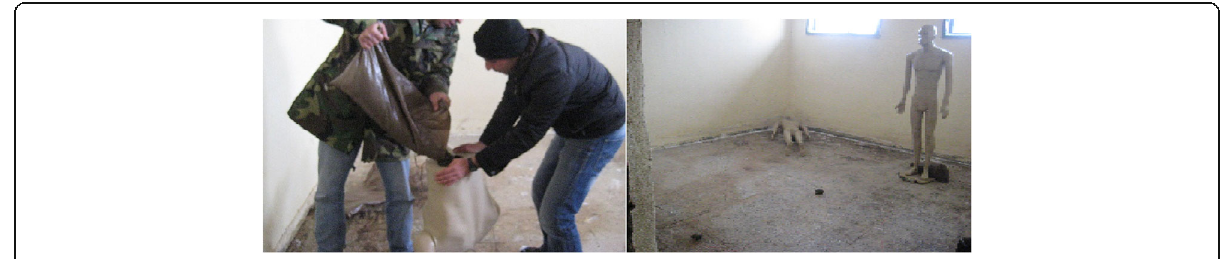
Fig. 9 The test mannequin preparation for test detonation